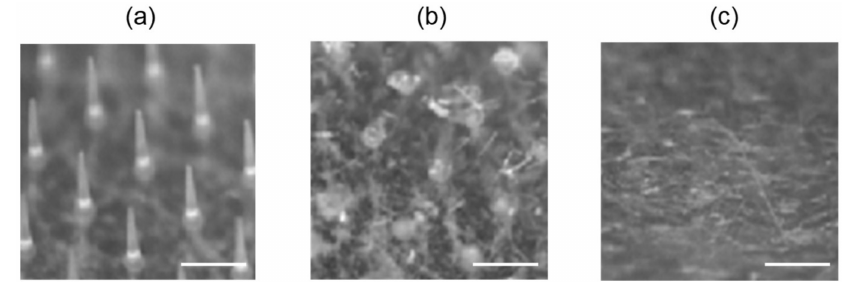
Figure 5. Dissolution process of needles after application of human parathyroid hormone (1-34) (PTH)-loaded microneedle arrays (MNs). ( a ) Before application, ( b ) 30 min, and ( c ) 60 min after application. Scale bars represent 800 µ m.